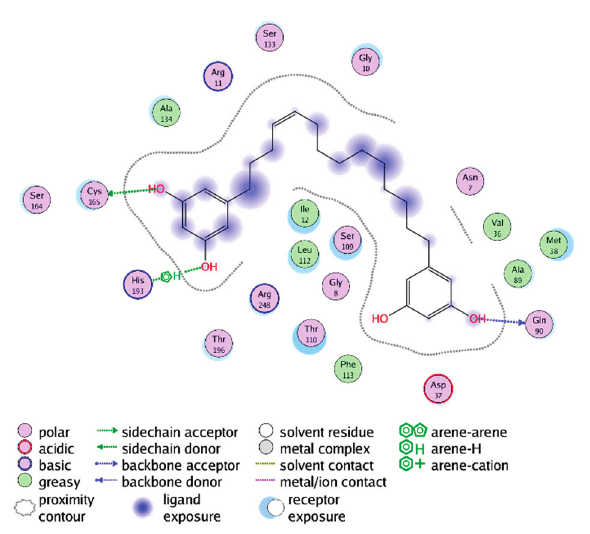
Figure 6. Interactions between the lowest energy docking pose of compound NP-014428 ( 5 ) and the NAD + binding site of Tb GAPDH (PDB-ID 2X0N).